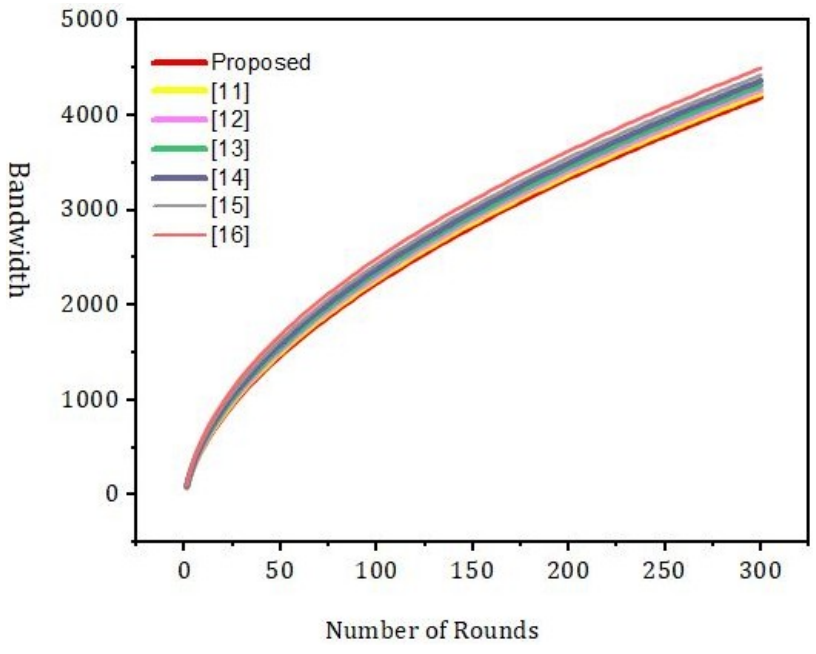
Figure 10. Simulation results based on the bandwidth and number of rounds.